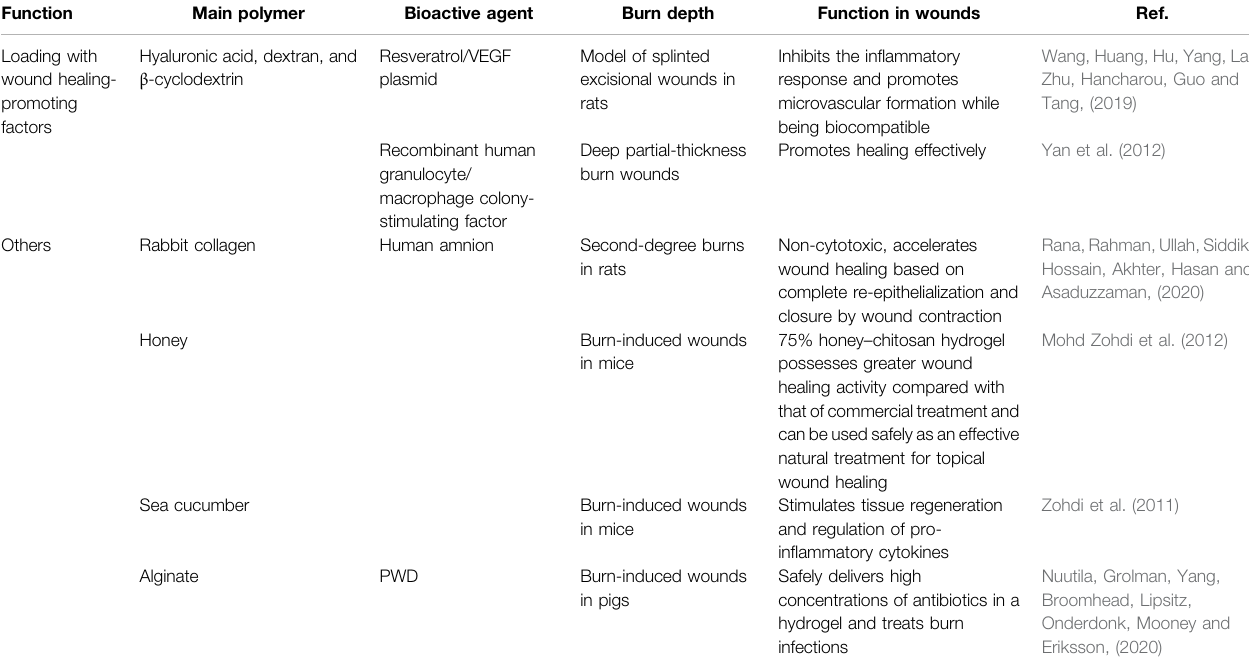
TABLE 1 | ( Continued ) Summary of commonly employed polymers in hydrogel dressings and their functions in wound